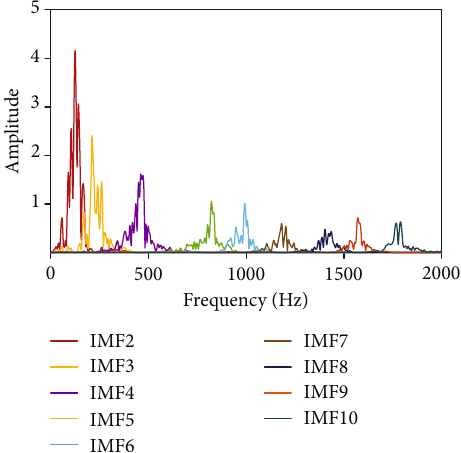
Figure 11: IHHO-VMD-MA spectrum